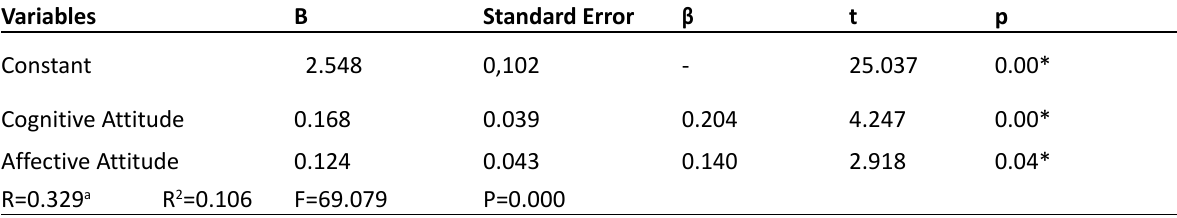
Table 5. Results of multiple regression analysis of attitude to physical education lesson predicting rejection dimension